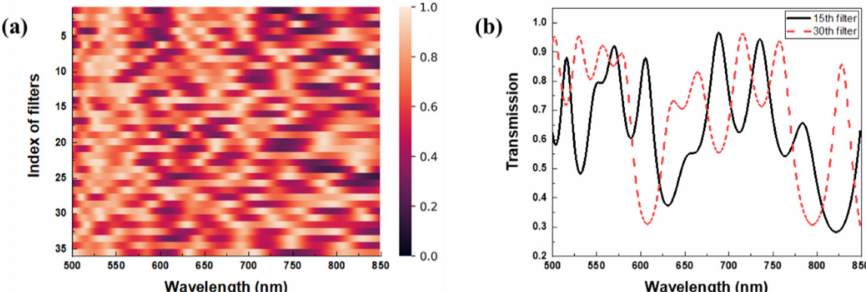
Figure 1. ( a ) Heatmap of the sensing matrix: each row represents the transmission spectrum of the designed thin-film filter. ( b ) Two transmission spectra corresponding to the 15th and 30th rows in the sensing